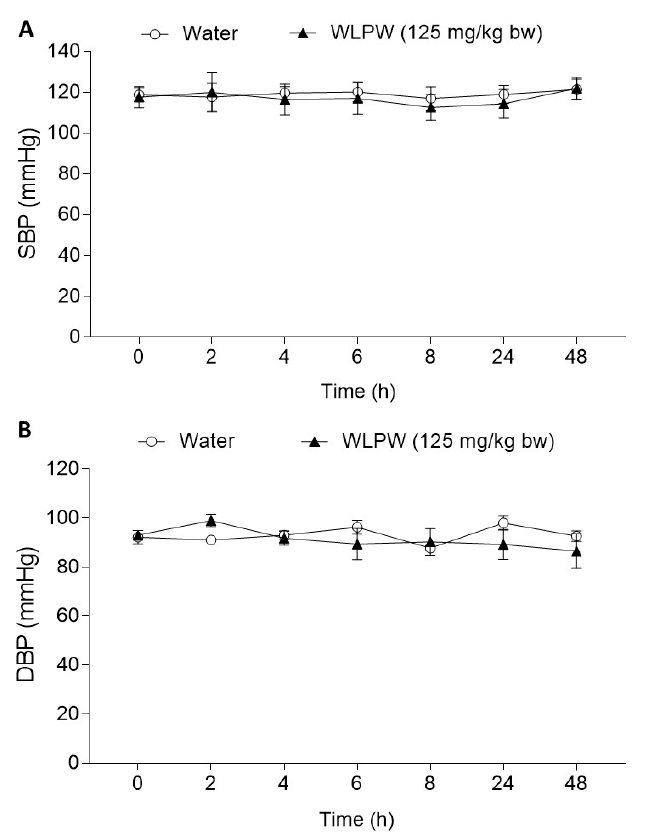
Figure 4. ( A ) Systolic blood pressure (SBP) and ( B ) diastolic blood pressure (DBP) of the Wistar– Kyoto rats before and after a single administration of water or dried wine lees powder (WLPW) (125 mg/kg bw). Data are expressed as mean ( n = 6) ± SEM. No significant differences ( p < 0.05) were found between both groups (two-way ANOVA).